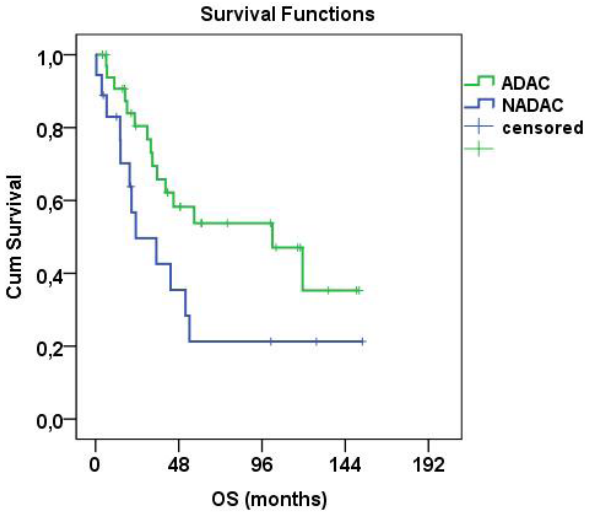
Fig. 1. Kaplan-Meier survival analysis of ADAC vs. NADAC